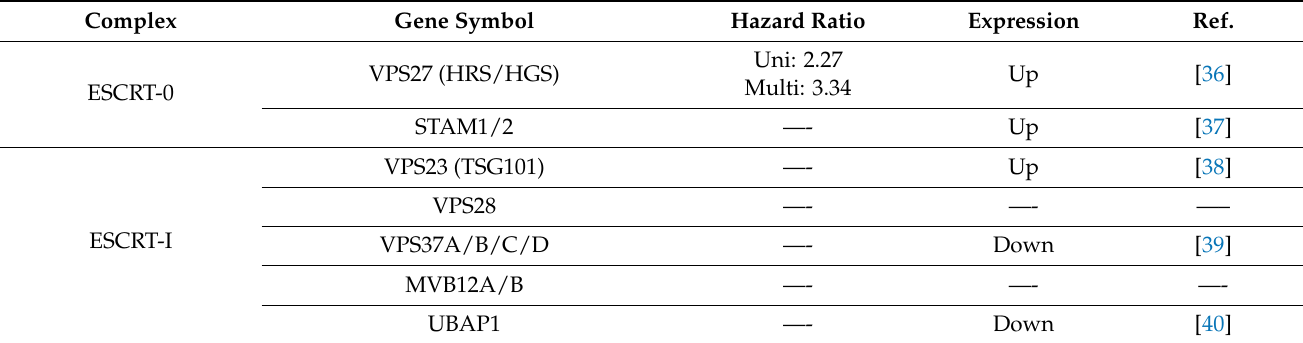
Table 1. Components of ESCRT complexes and regulators in colorectal cancer exocytosis. Complex Gene Symbol Hazard